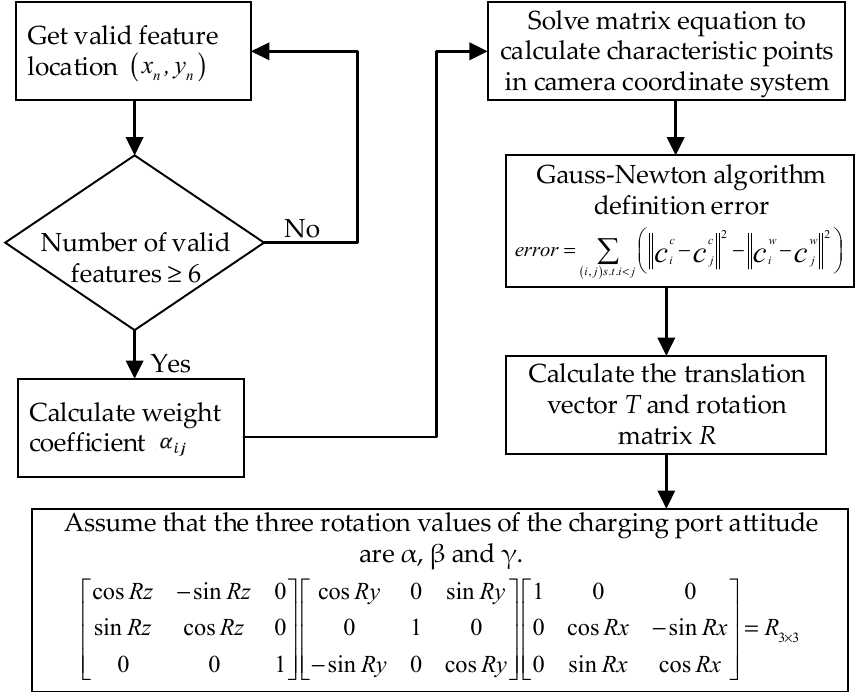
Figure 6. EPnP algorithm location process.